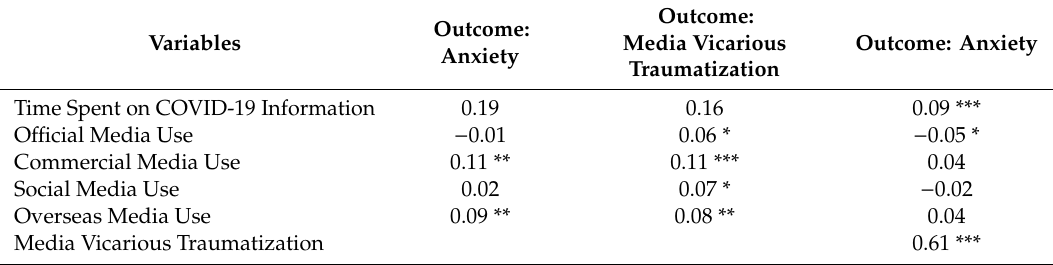
Table 2. Testing the mediation e ff ect of media vicarious traumatization between media exposure and